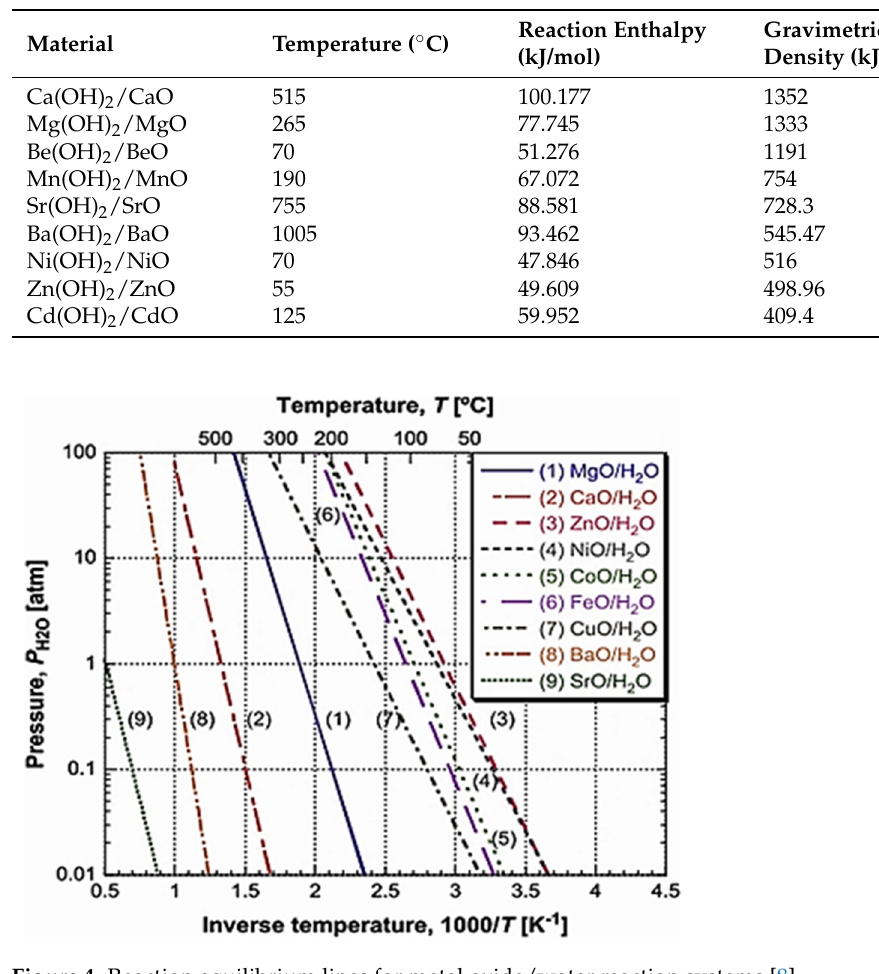
Figure 4. Reaction equilibrium lines for metal oxide/water reaction systems [8].